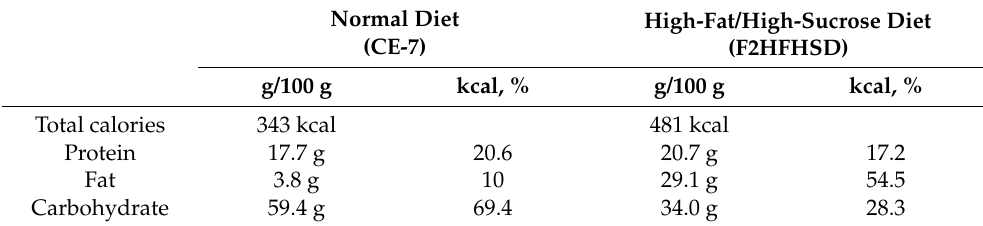
Table 1. Composition of Normal Diet and High-Fat/High-Sucrose Diet. Normal Diet High-Fat/High-Sucrose Diet